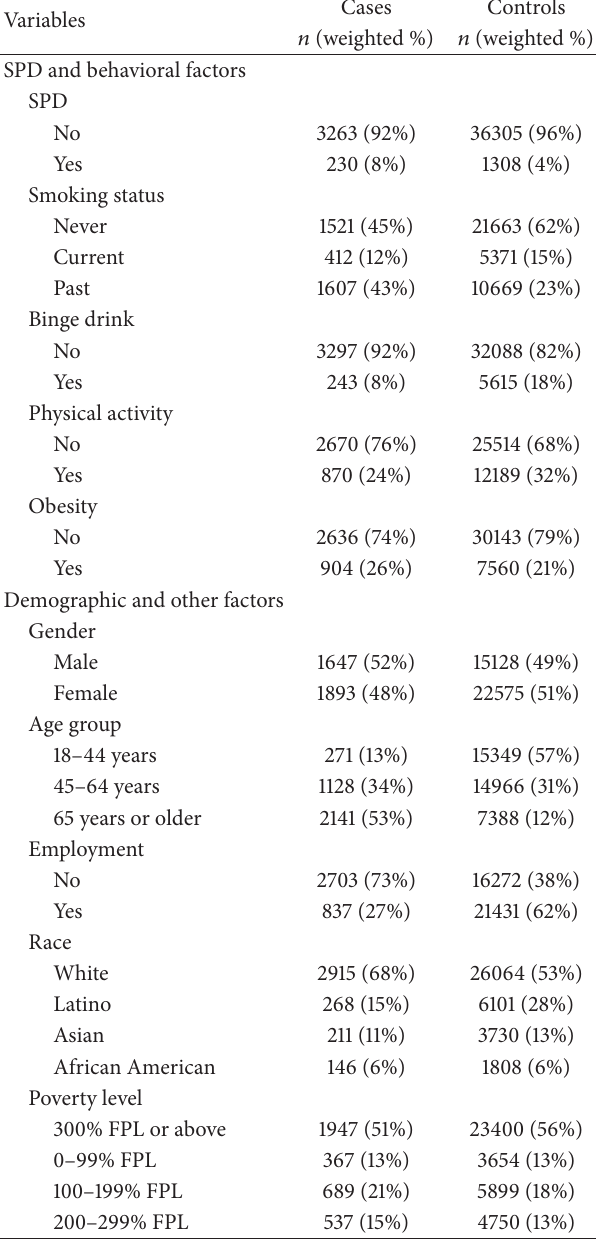
Table 1: Subjects characteristics using 2005 California Health Interview Survey ( 𝑁 = 41, 243